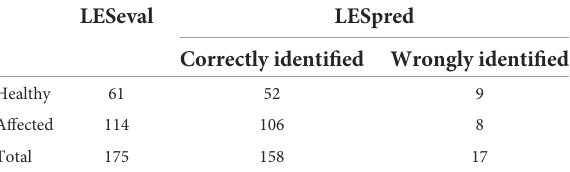
TABLE 2 Comparison between the visually assessed sole hemorrhages (LESeval), observed during trimming, and those predicted by the equation (LESpred).